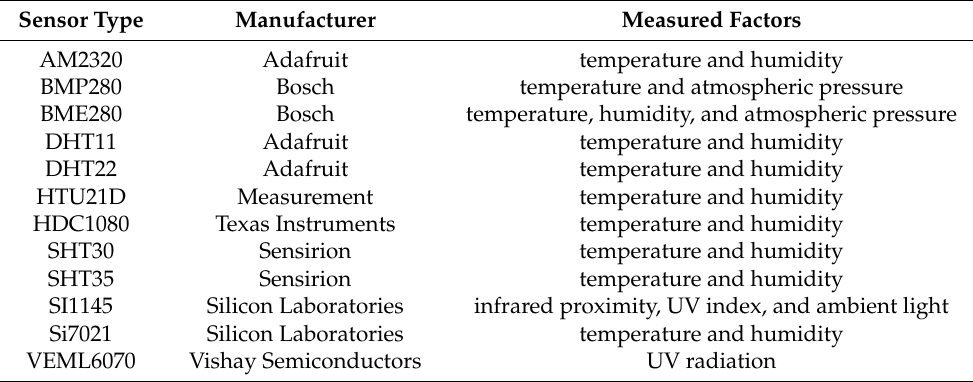
(Table 2): eight temperature and humidity sensors, two UV index sensors, one air pressure and temperature sensor, and one air pressure, temperature, and humidity sensor. The considered sensors were produced by different manufacturers. They covered a wide spectrum of response times (from milliseconds to seconds) and applications (from heating, ventilation, and air conditioning systems, through weather stations, to smart wearable devices, such as smartwatches, smartphones, and smartbands). Table 2. Sensors that were the subject of